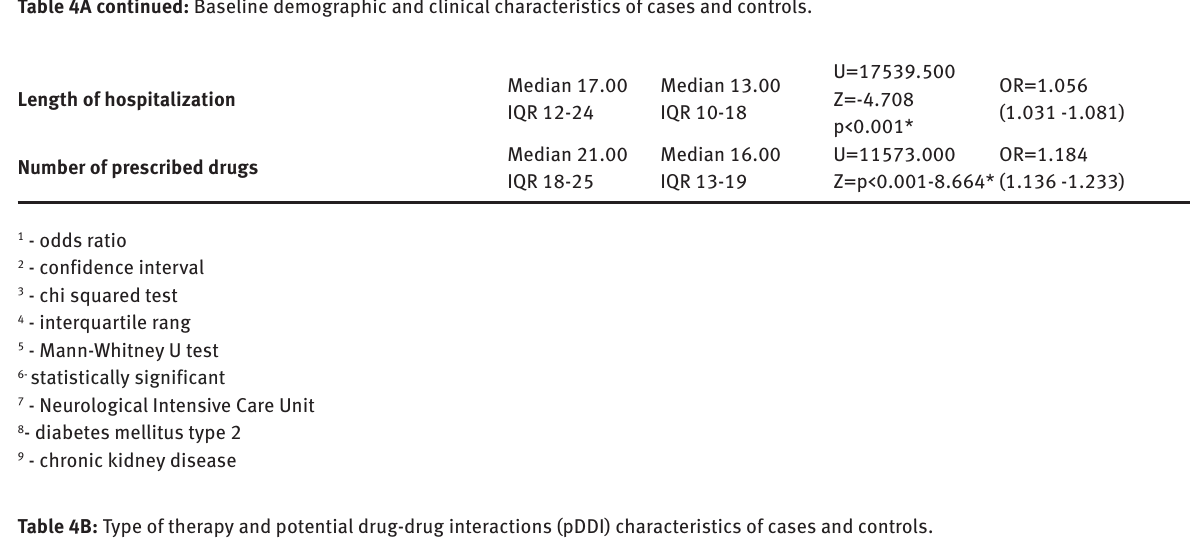
Table 4A continued: Baseline demographic and clinical characteristics of cases and controls.